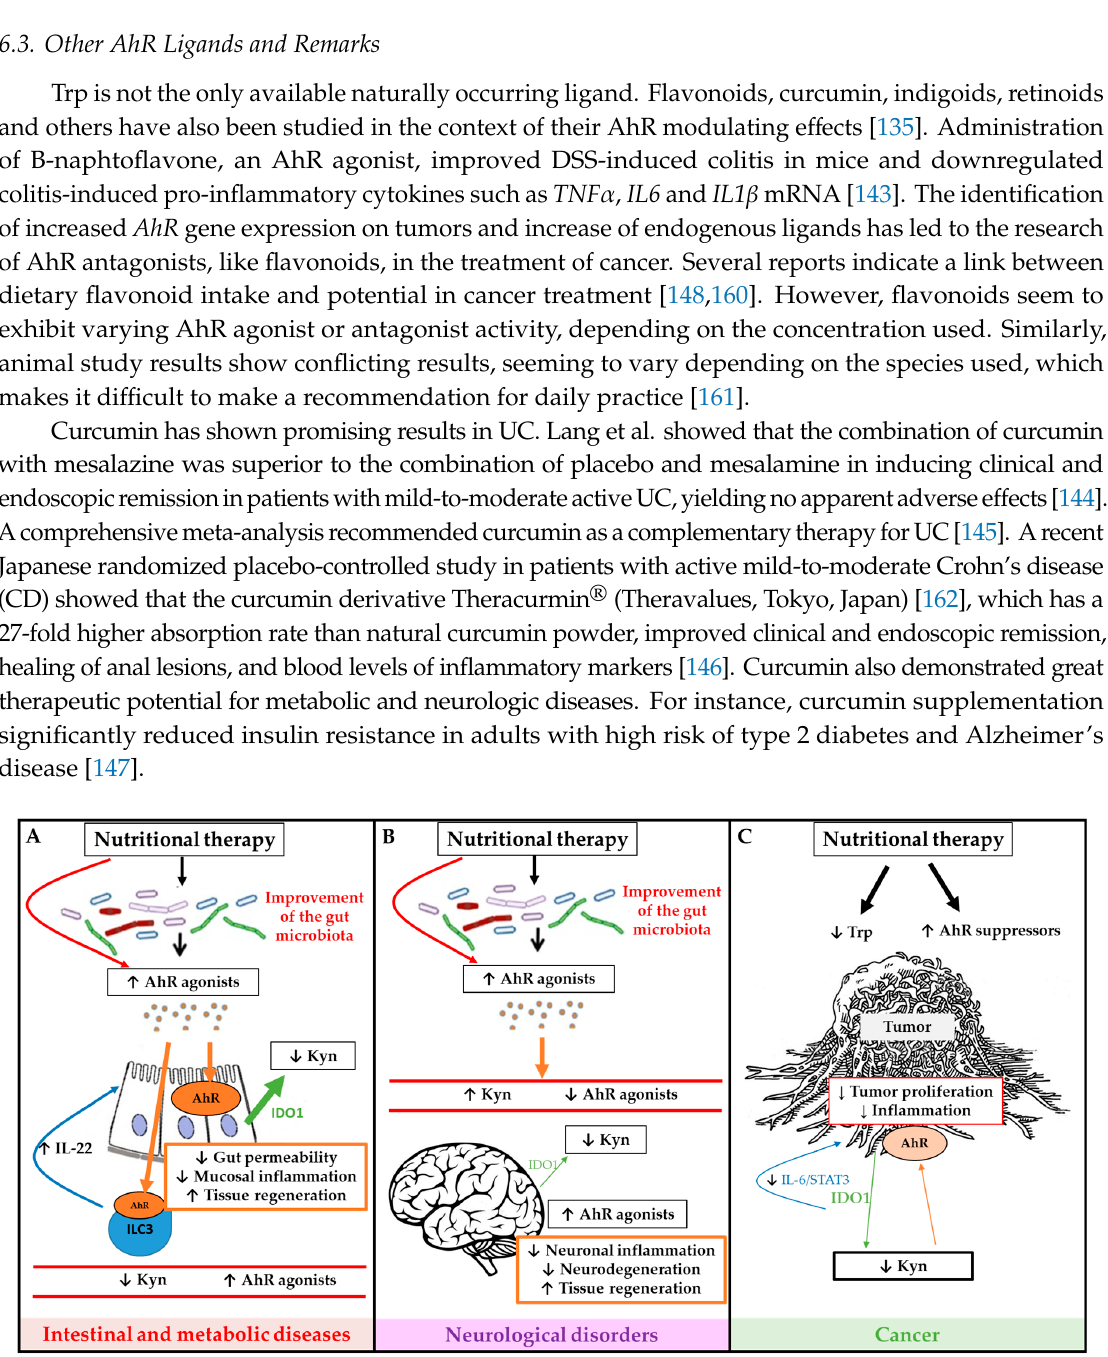
Figure 3. Schematic overview of potential mechanisms of nutritional therapies to modulate microbiota dependent tryptophan (Trp) metabolism and AhR signaling activation in order to improve outcome of intestinal and metabolic diseases ( A ), neurological diseases ( B ) and cancer ( C ). Green arrows represent IDO1 production, large green arrows represent high production and the narrow arrows represent low production. Brown arrows represent AhR activation, large brown arrows represent high activation of AhR, and the narrow arrows represent low activation of AhR.